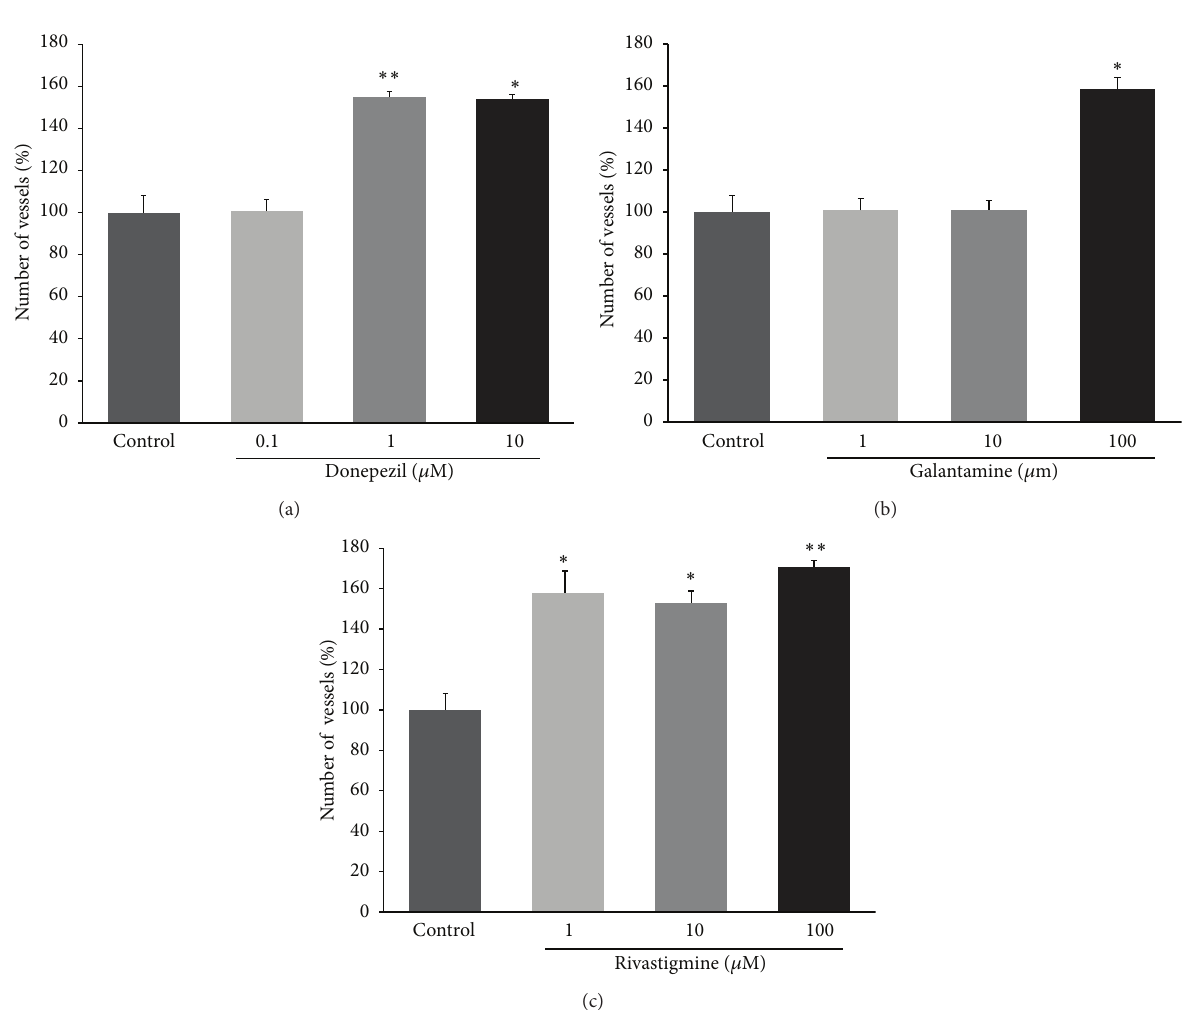
Figure 3: Effects of AChE inhibitors on angiogenesis in chicken chorioallantoic membrane model. The percent of vascularity was normalized against untreated control eggs. Data are mean ± SD of two independent experiments performed in triplicate. ∗ 𝑃 < 0.05 , ∗∗ 𝑃 < 0.01 , versus control.